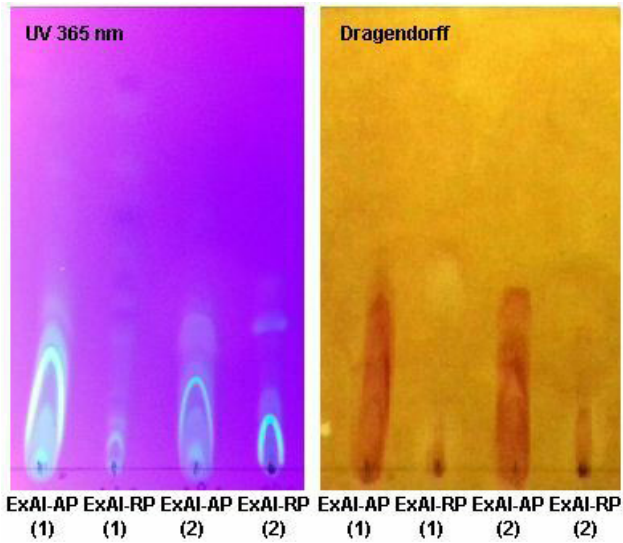
FIGURE 2 - Confirmatio n of the presence of the alkaloids in the various extracts obtained by thin layer chromatography (TLC) analysis. ( 1): First extraction protocol; (2): Second extraction protocol; ExAl-AP: Extract of Alkaloids from Aerial Part; ExAl-RP: Extract of Alkaloids from Root Part; Dragendorff: Reagent used for alkaloid revelation, UV 365 nm: Ultraviolet light at a wavelength of 365